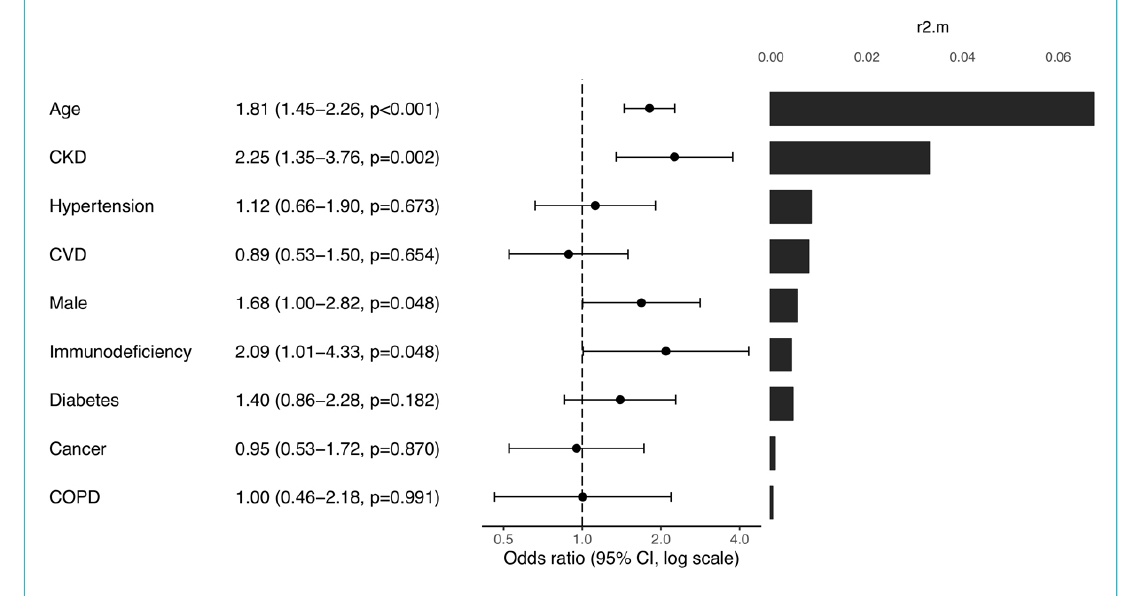
Figure 3: Odds ratio plot displaying the adjusted odds ratio (OR) with the 95% confidence interval (CI) of each variable to predict in-hospital mortality over all three waves. On the right side the average contribution of each variable is plotted on a horizontal scale representing the aver- age contribution of each variable to the model using McFadden R. A table with all the crude and fully adjusted effect estimates, 95% CI and p- values is presented in the appendix. CKD = chronic kidney disease; CVD = cardiovascular